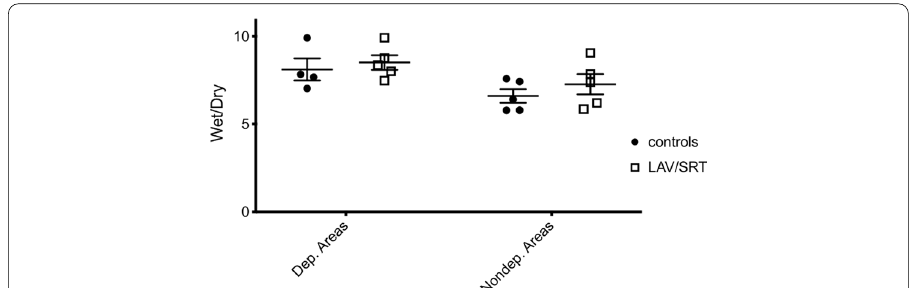
Fig. 4 Wet-to-dry (W/D) lung weight ratios from dependent (dep.) lung and non-dependent (nondep.) lung tissue biopsies